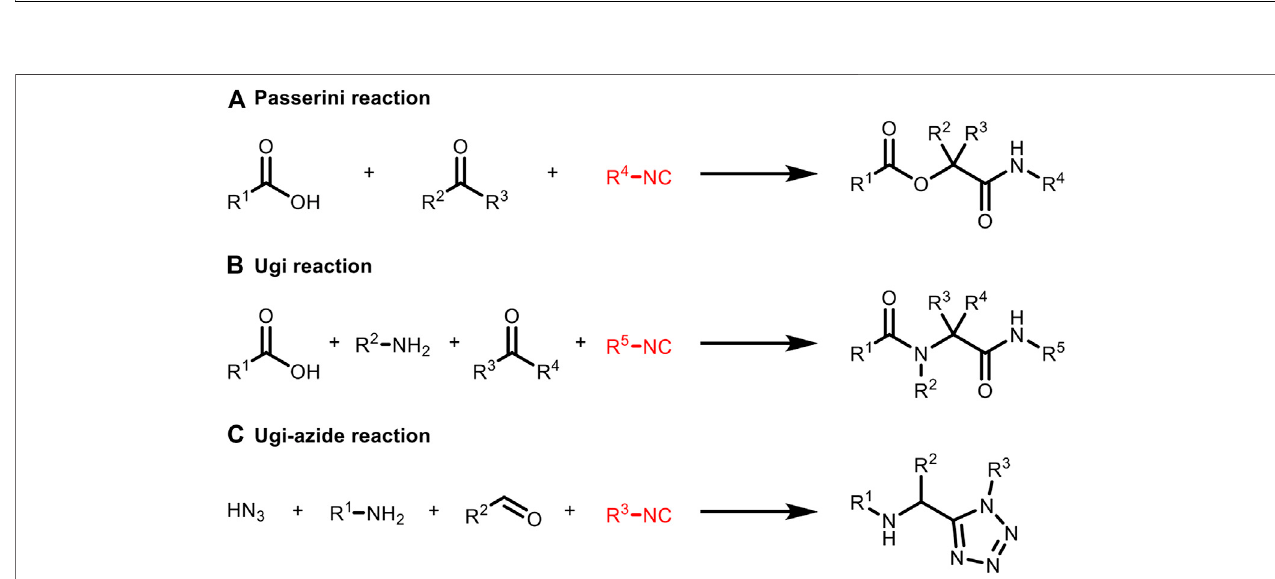
FIGURE 6 | Isocyanide-based MCRs applied to bioconjugation include (A) Passerini reaction, (B) Ugi reaction and (C) Ugi-azide reaction. All the substituents (R 1 − R 5 ) can be biomolecular fragments.